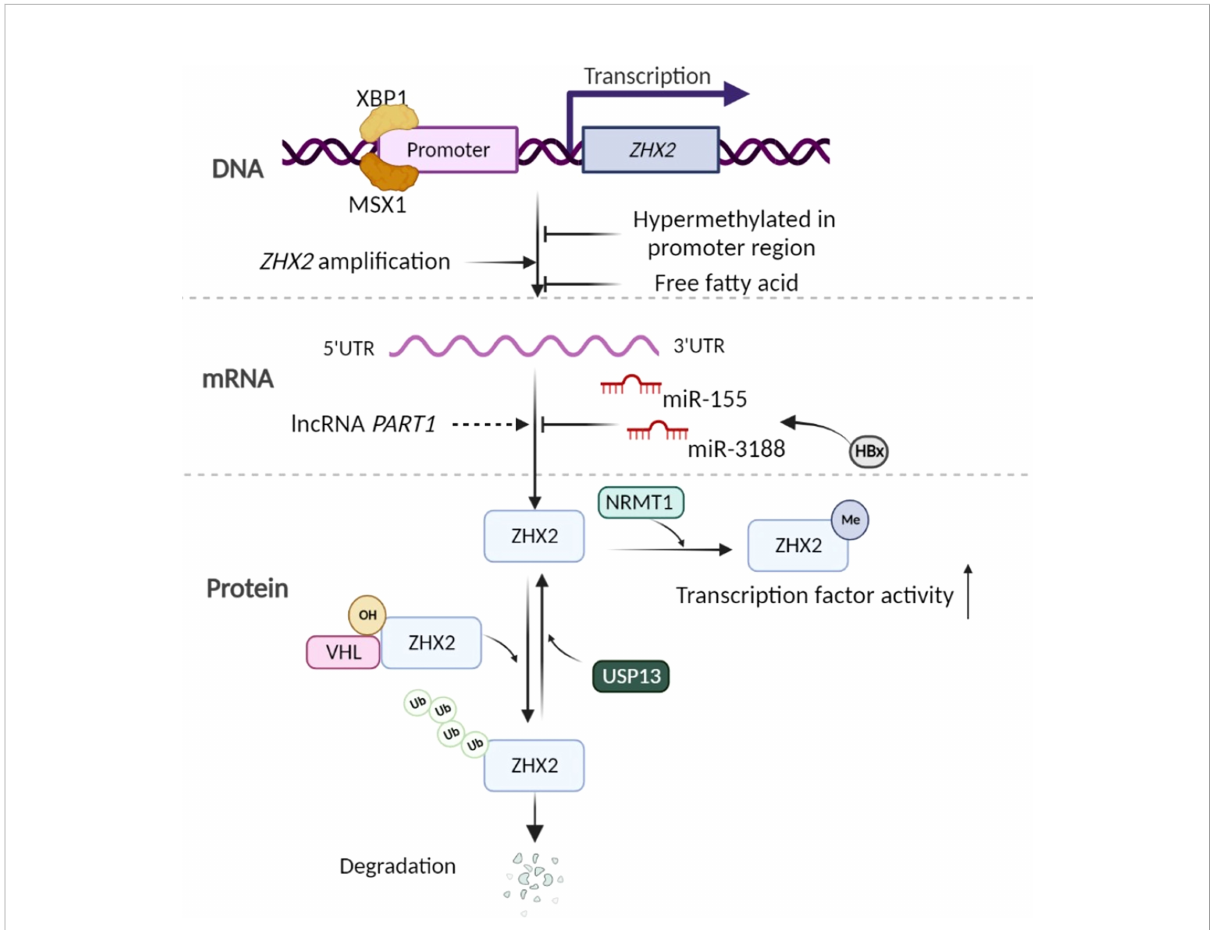
FIGURE 1 Control of ZHX2 expression. At the gene and transcription level, some transcription factors, hypermethylation of ZHX2 promotor, and cellular stimuli such as free fatty acid are known to regulate ZHX2 transcription. Concurrently, ZHX2 gene ampli fi cation contributes to its enhanced expression in cancer. At the post-transcription level, miR-155 and miR-3188 upregulated by HBx inhibit ZHX2 mRNA translation, but lncRNA PART1 promotes ZHX2 mRNA level by altering the miRNA landscape. At the PTMs level, hydroxylated ZHX2 protein is recognized and degraded by E3 ubiquitin ligase VHL, which is inhibited by USP13-induced deubiquitination, while NRMT1-mediated N a -methylation of ZHX2 promotes its transcription factor activity. Created using